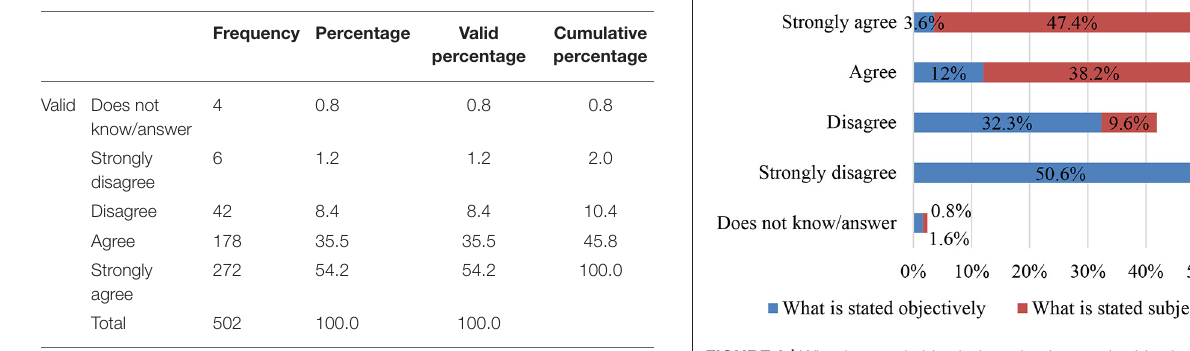
TABLE 4 | Item 15. Argumentation as a space for discussion.